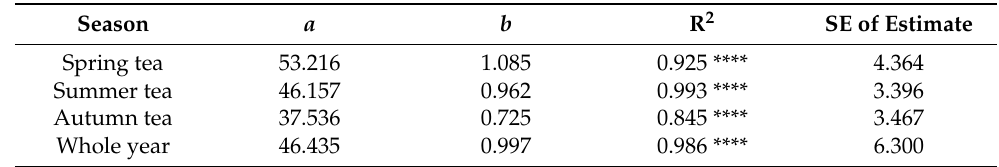
Figure 7. Relationships between annual ( a ) and seasonal ( b ) N contents (N ys ) with yields (Y ys ) of young shoots harvested under different standards across the three experimental years. Coefficients of regression (N ys = a × Y ysb ) are presented in Table 2. Table 2. Regression coefficients of annual and seasonal N contents (N ys ) against yields (Y ys ) according to the empirical formula (N ys = a × Y ysb ) ( n =